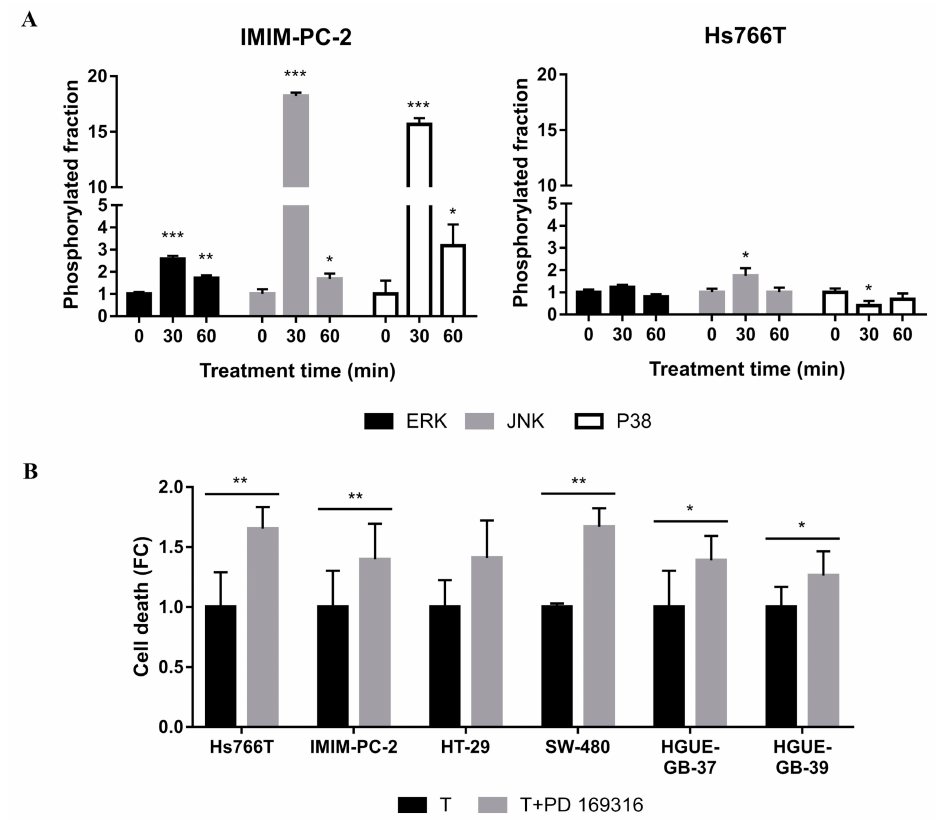
Figure 4. MAPK implication in CLytA-DAAO-induced cell death. ( A ) IMIM-PC-2 and Hs766T cell lines were treated with CLytA-DAAO and D-Ala for 30 min and 1 h and ERK, JNK and P38 phosphorylation was determined by ELISA assay. Data represent the fraction of MAPK phosphorylation, normalizing the phosphorylation in control cells as 1 ± SD with n ≥ 3. ( B ) Hs766T, IMIM-PC-2, HT-29, SW-480, HGUE-GB-37 and HGUE-GB-39 cell lines were treated with CLytA-DAAO and D-Ala (T) in the presence or absence of PD 169316, a p38 inhibitor, for 24 h and cell viability was determined by flow cytometry. Data represent the cell death fraction, normalizing the treatment with CLytA-DAAO as 1 ± SD with n ≥ 3. * indicates a p -value < 0.05, ** p -value < 0.01 and *** p -value <